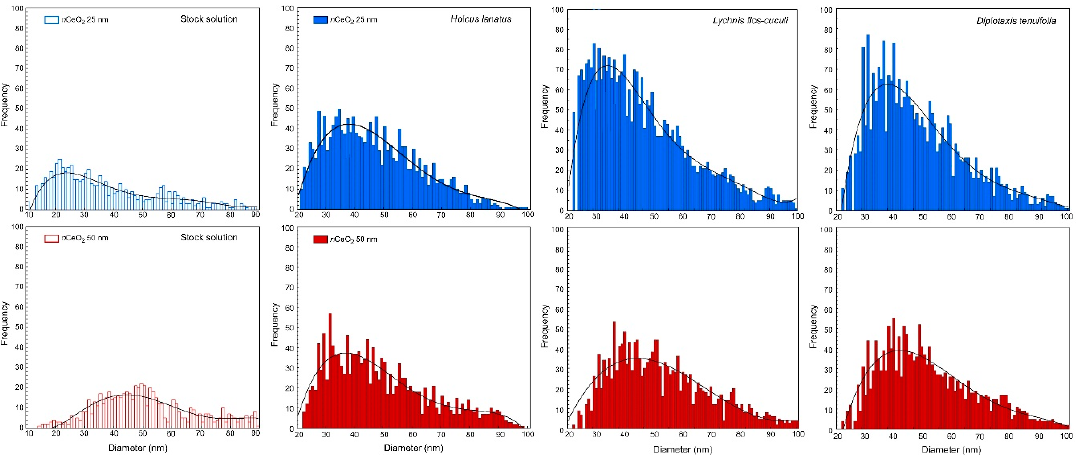
Figure 2. Particle size distributions of, respectively, n CeO 2 25 nm and n CeO 2 50 nm stock solutions (open bars) and after enzyme treatment of seedlings of H. lanatus , L. flos-cuculi and D. tenuifolia (closed bars) treated with 20 mg L − 1 of n CeO 2 .